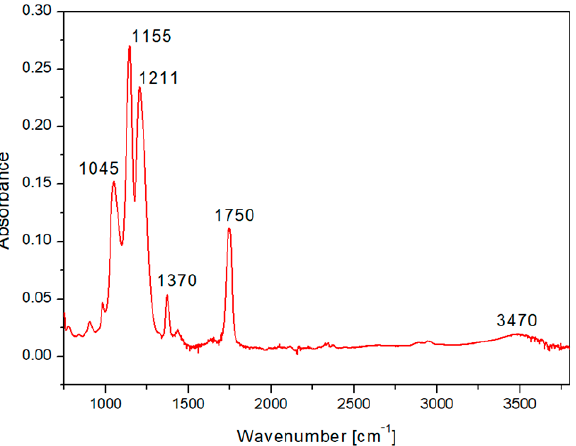
Figure 6. The FTIR spectrum of fluorinated ethylene propylene (FEP) with the prepared honeycomb-like (HCP) structure from acetate cellulose and with an Ag layer sputtered for 500 s.